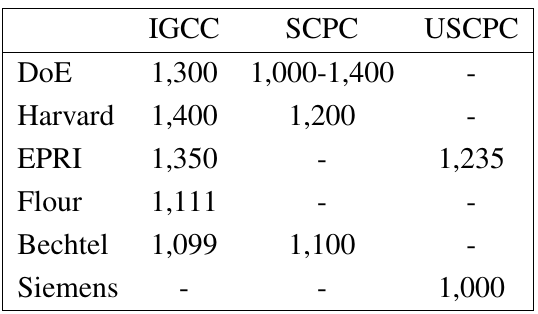
Table 5. Capital cost ($/kW) for different